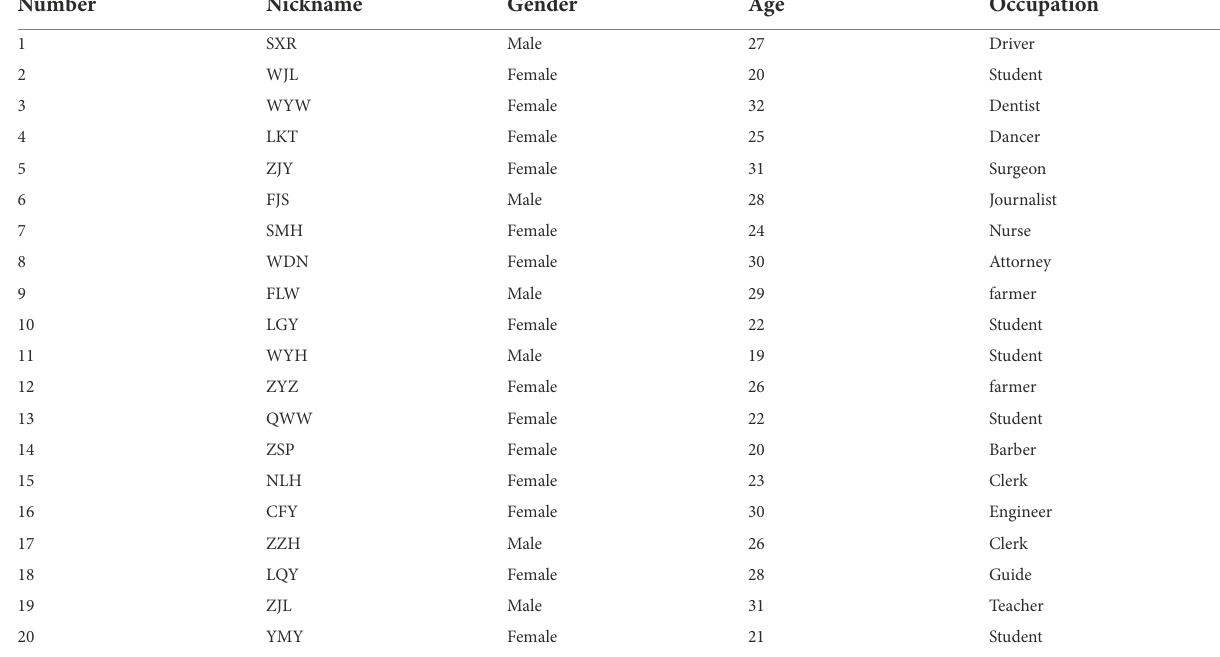
TABLE 1 Table of interviewers.